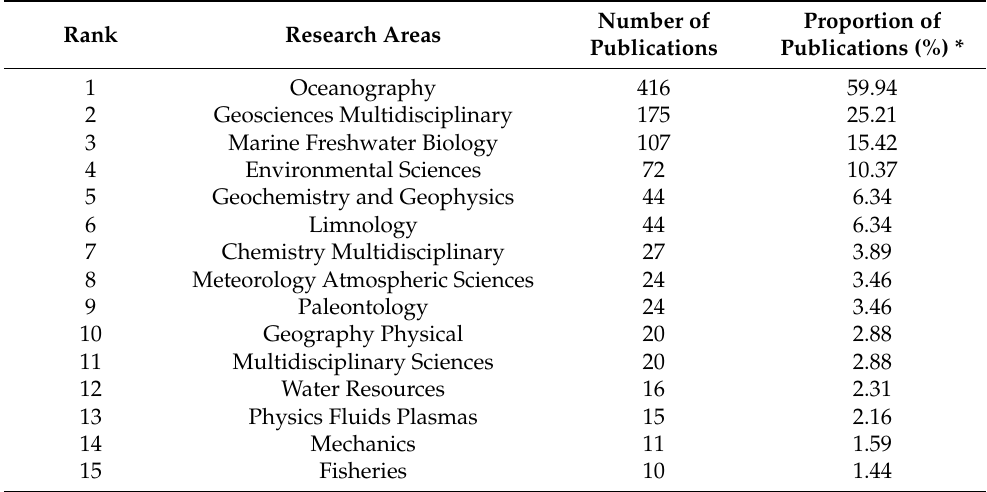
Table 2. Top 15 research areas from 1990 to 2022 with the most publications on nepheloid